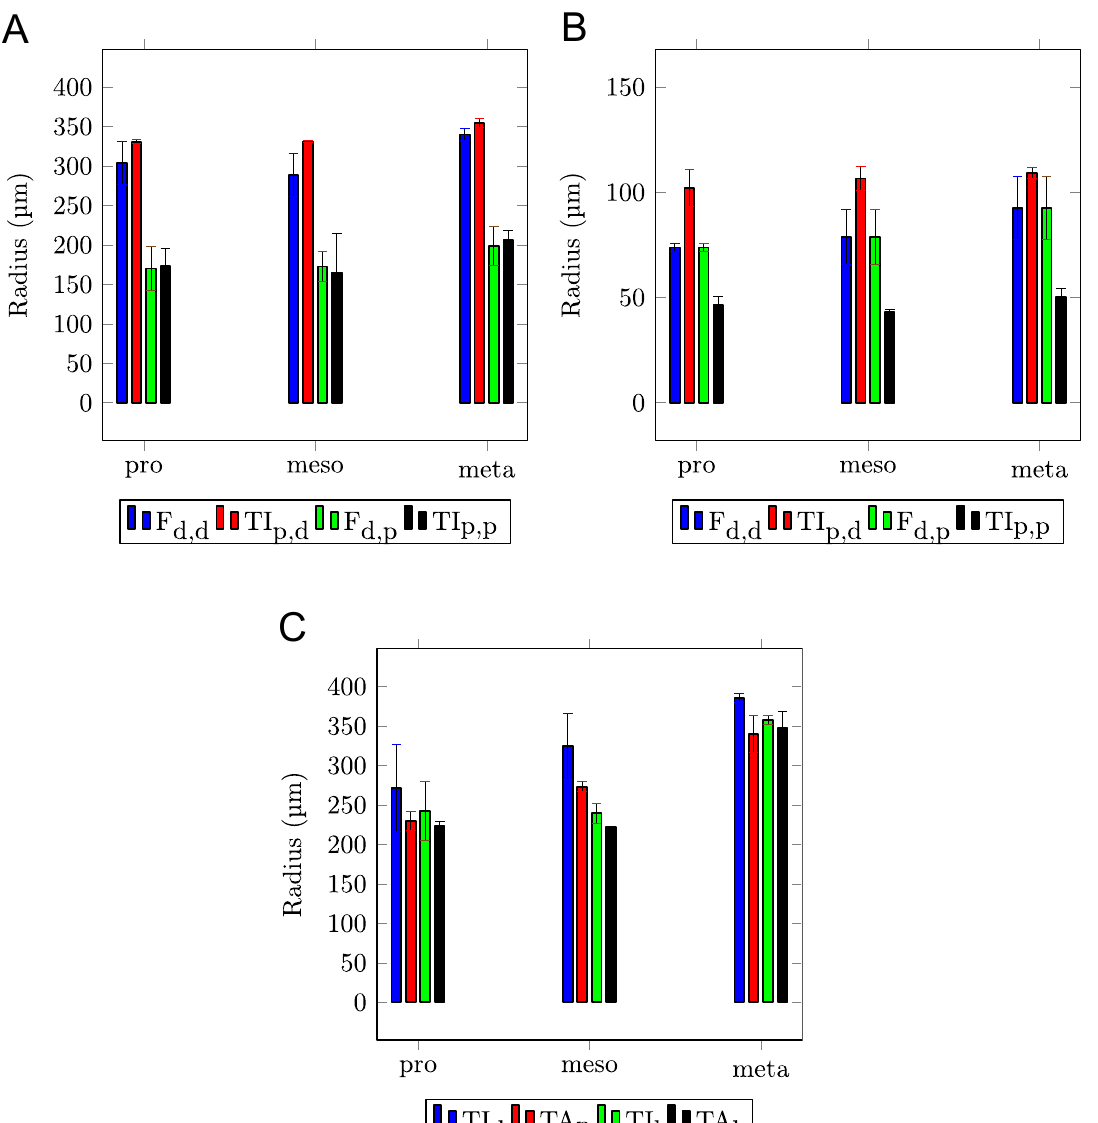
Figure 5. Radii of the contacting surfaces in ( A , B ) the femur–tibia and ( C ) the tibia–tarsus leg joints measured by confocal laser scanning microscopy (CLSM). The data for both counterparts of each joint are shown next to each other. Error bars show standard deviations of the means. F d,p : the distal end of the femur, the proximal condyle; TI p,p : the proximal end of the tibia, the proximal condyle; F d,d : the distal end of the femur, the distal condyle; TI p,d : the proximal end of the tibia, the distal condyle; TI d : the distal end and the condyle of the tibia; TI l : the lateral curvature of the distal tibia condyle; TA p : the proximal end and the condyle of the tarsus; TA l : the lateral curvature of the tarsus condyle; pro: prothoracic leg; meso: mesothoracic leg; meta: metathoracic leg. After the derivation of the primary profile from the measured data, the waviness of the surfaces was examined. A second ‐ order shape deviation can be demonstrated for both the ft and tt joints. In the ft joint, the proximal and distal condyles of the TI are covered by a tooth ‐ like microstructure